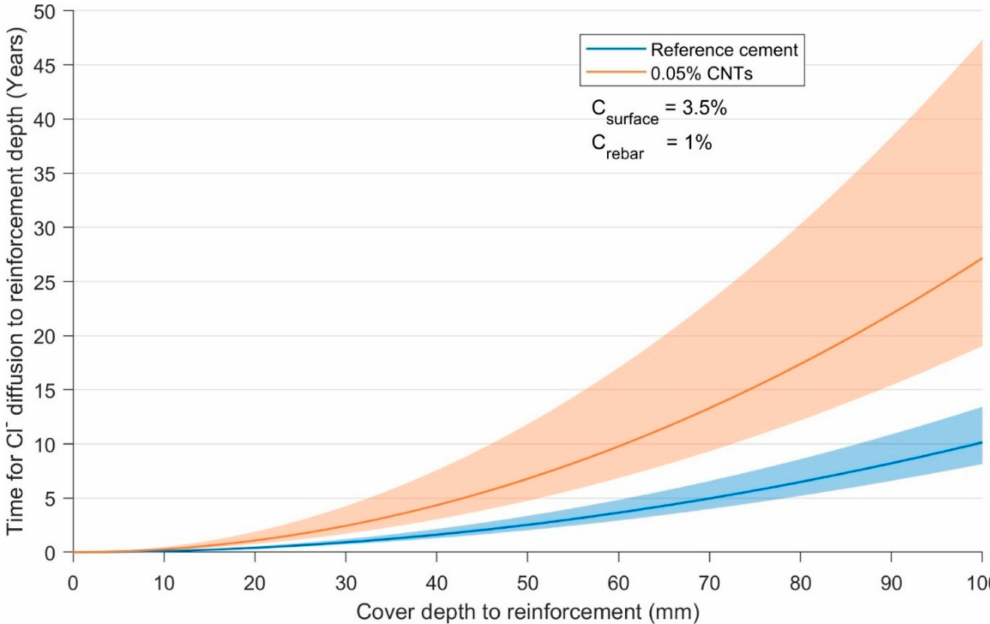
Figure 12. Calculated initiation time of corrosion as the function of cover depth to reinforcement, comparing apparent chloride di ff usion coe ffi cients for specimens R 1 and C 05 , assuming surface chloride concentration of 3.5% and a critical chloride threshold of 1% (by the weight of cement). Shaded regions denote values ± 1 s.d. of apparent di ff usion coe ffi cient.